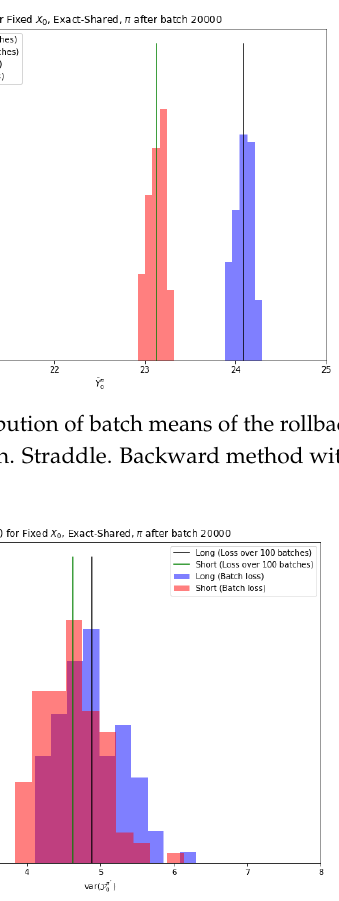
Figure 8. Distribution of batch losses for the rollback Y π the optimization. Straddle. Backward method with exact backward step. Single DNN for π . Batch size